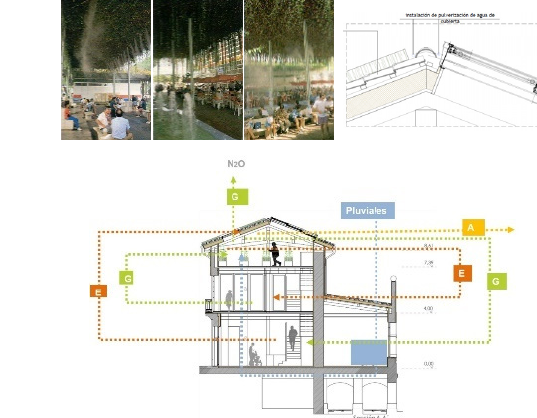
Figure 11. Drawings of the green urban infrastructure designs in (developed by the authors).